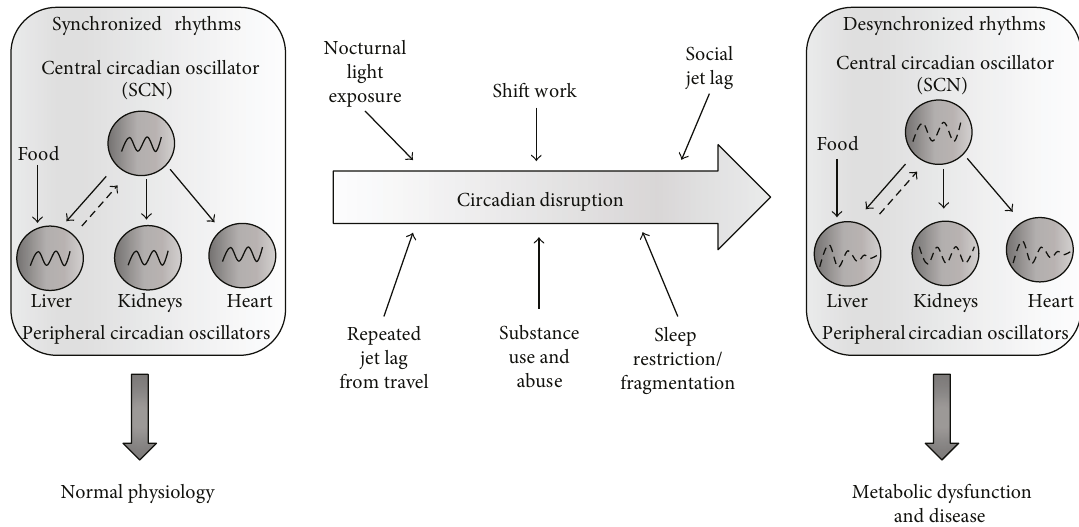
Figure 3: Central and peripheral circadian regulation of metabolic function. Under normal conditions, the central circadian oscillator in the SCN is entrained by light and synchronizes peripheral oscillators. Meal timing can also entrain the liver oscillators. Environmental perturbations such as shift work, jet lag, sleep restriction, and substance abuse create misalignment between the SCN and the peripheral oscillators resulting in metabolic syndromes and